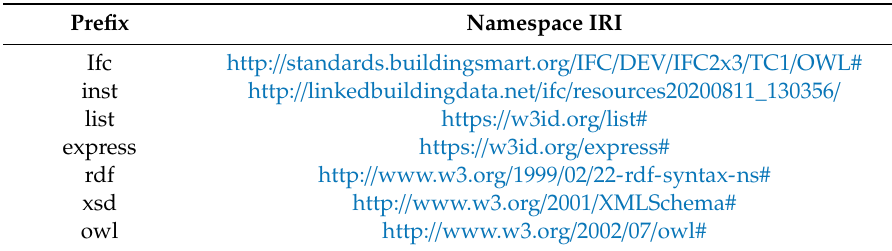
Table 3. The prefixes in this Norwegian case.